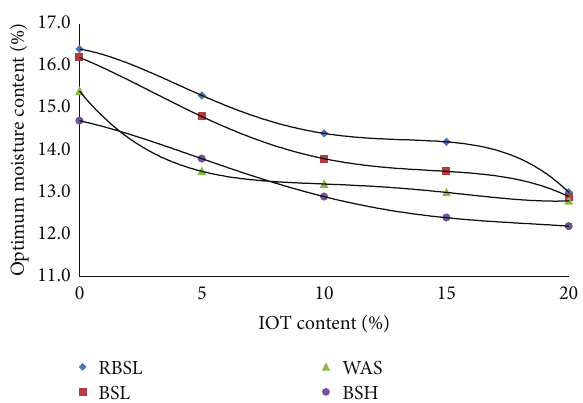
Figure 3: Optimum moisture content versus iron ore tailings content for soil compacted using four types of compactive efforts.